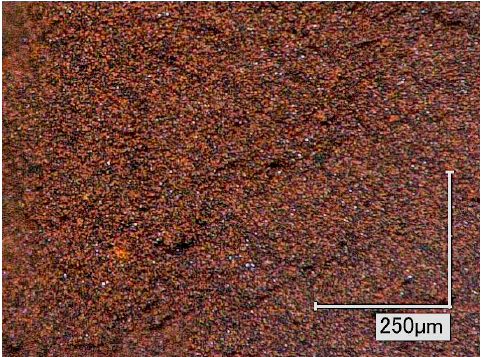
Figure 3. Optical image of homogenised CdO-C mixture at magnification 200×.